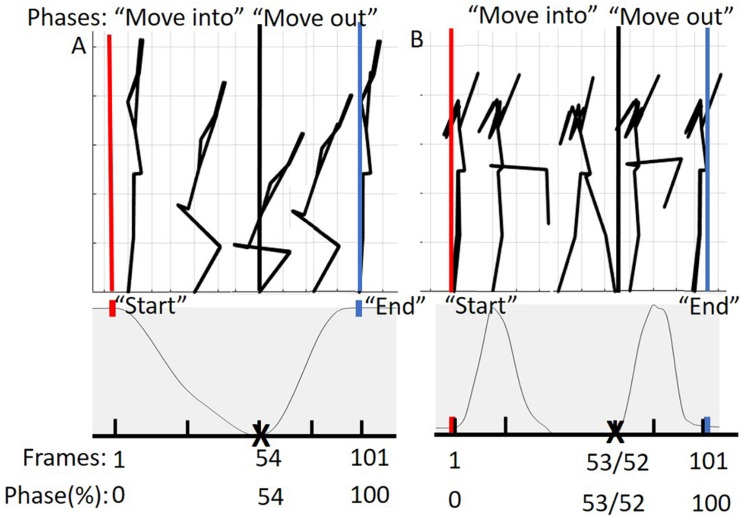
(A) Represents the phases of the DS movement from 0 to 100%. The “move into” phase is contained by the red and black bars and in between the black and blue bars is the “move out” phase. The below graph represents tracking of the suprasternal notch marker to determine 50% of the movement (maximum squat depth) as well as define “start” and “end” points of the movement. (B) Represents the phases of the hurdle step movement from 0 to 100%. The “move into” phase is contained by the red and black bars and in between the black and blue bars is the “move out” phase. The graph below represents tracking of the right (LHS) or left (RHS) calcaneus marker to determine 50% of the movement (end of heel touch) as well as define “start” and “end” points of the RHS and LHS, respectively.